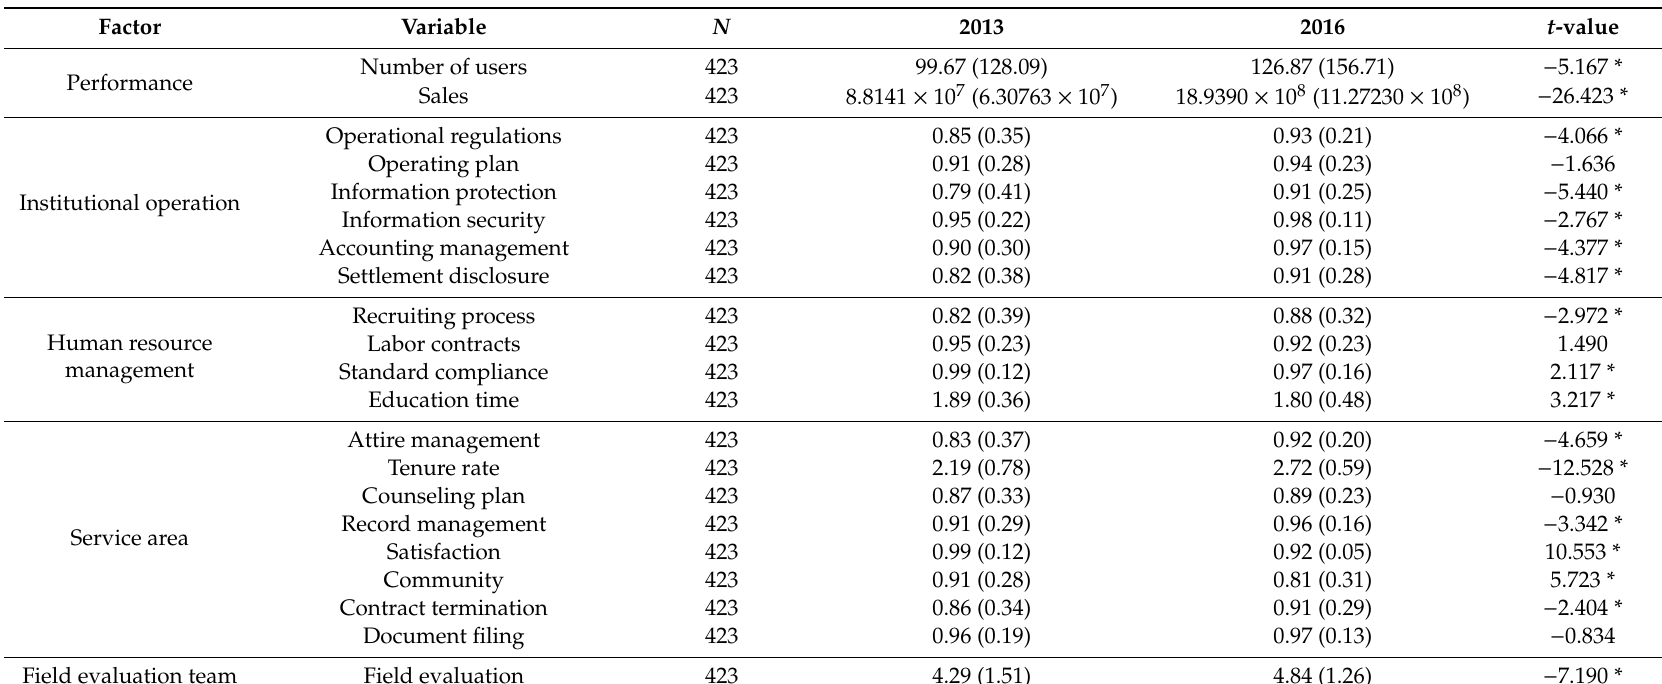
Table 2. Common indexes for QE of social services in 2013 and